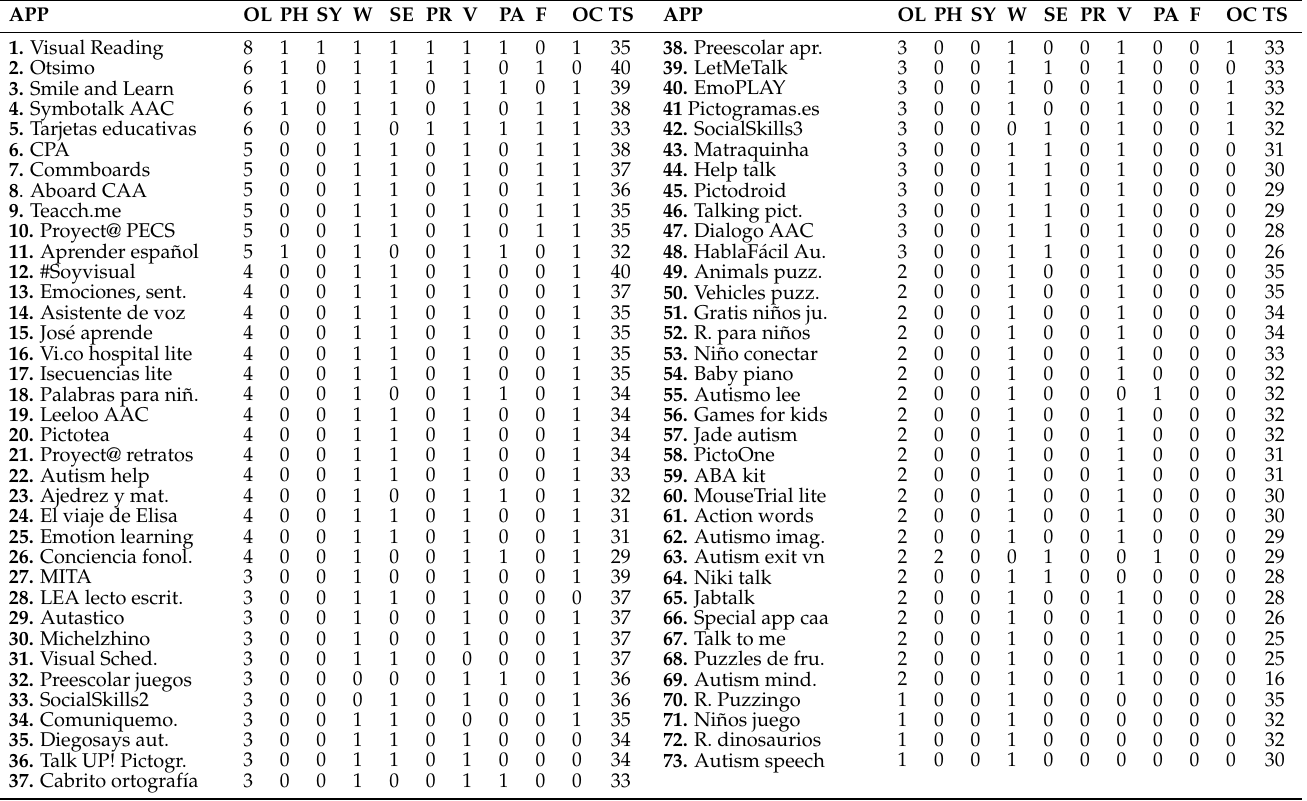
Table 5. Apps focused on oral language, ordered according to the score obtained in this skill and the sub-areas it comprises. APP OL PH SY W SE PR V PA F